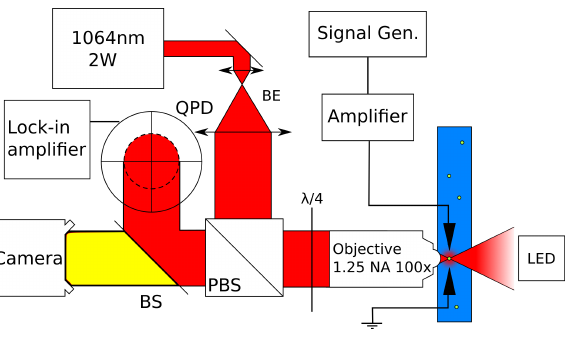
Figure 2. Schematic of the optical tweezer setup in the backscat- tering